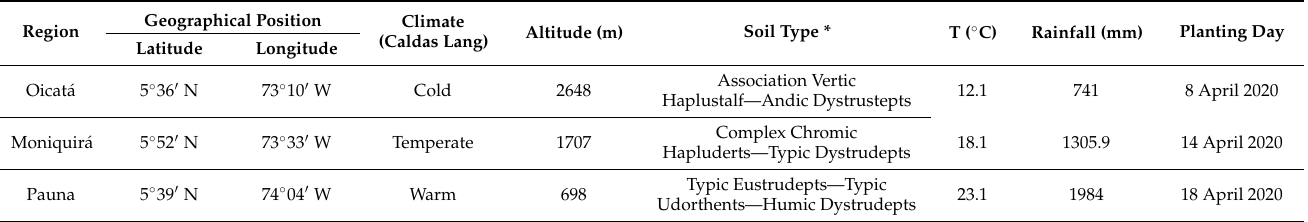
Table 1. Location and edaphoclimatic description of the experimental